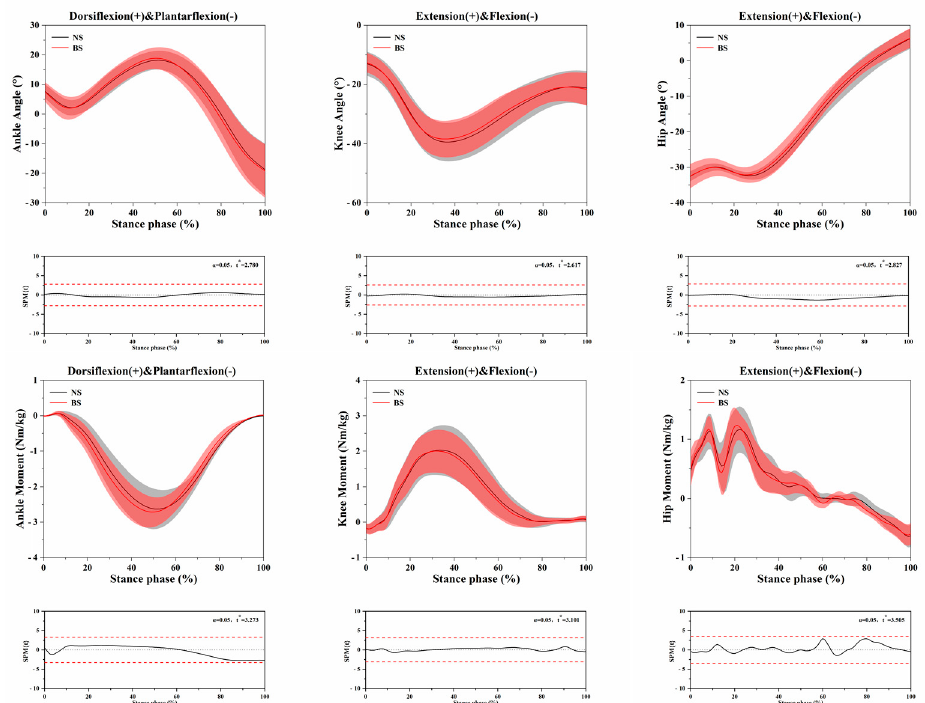
Figure 5. Illustration of the results between the NS and BS lower limb showing the statistical parametric mapping outputs for the angle and moment of the ankle, knee, and hip during the running stance phase. The values of t* are shown on the left of each image. Grey shades represent the significant differences and t -values of the SPM for all participants (post hoc results; dashed red lines represent the results at a p = 0.05 level). NSs, normal shoes; BSs, bionic shoes.